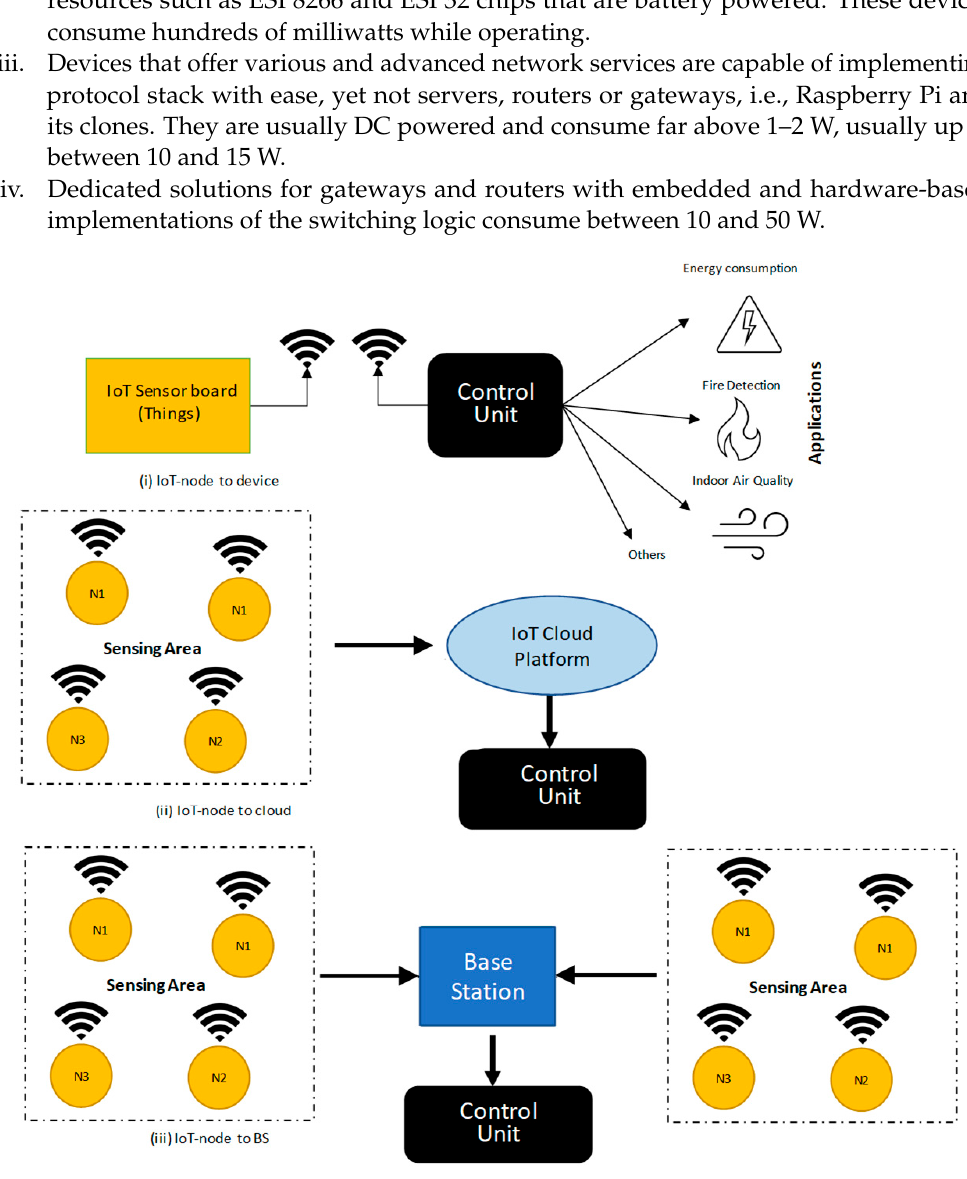
Figure 3. Structures of IoT communication models.